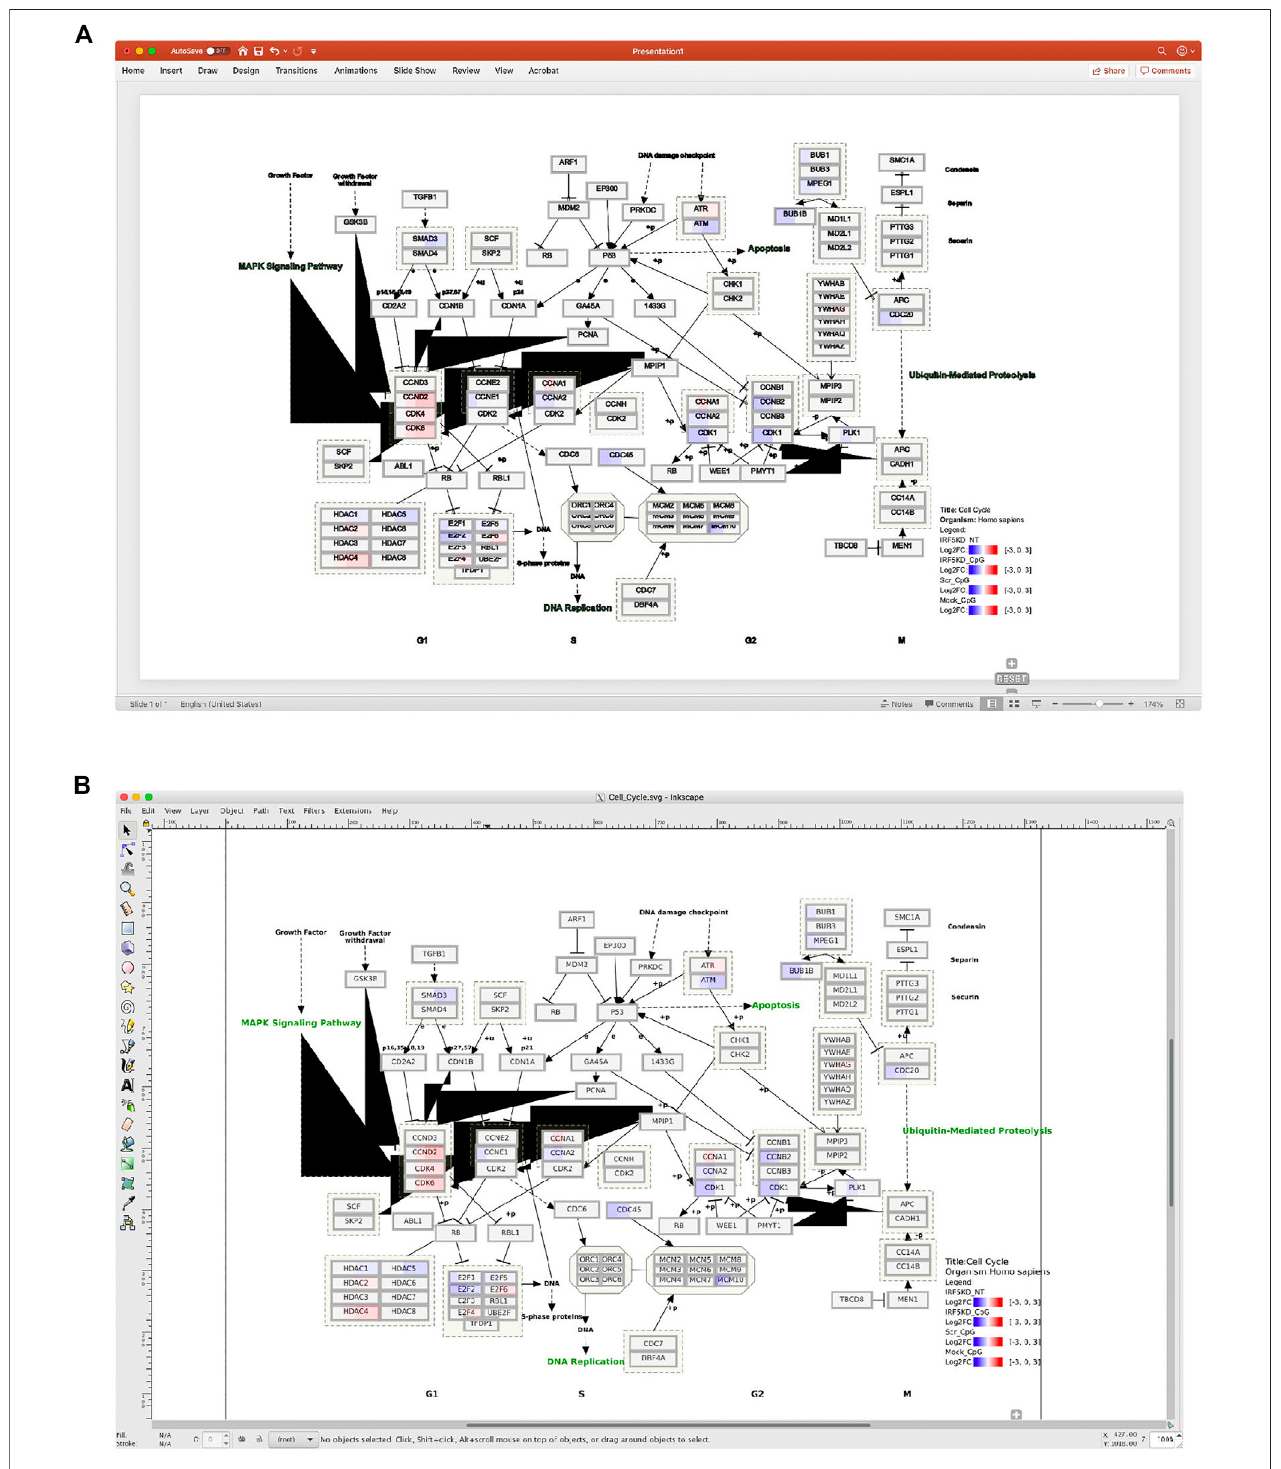
FIGURE 2 | An example of a pathway diagram from WikiPathways is not properly rendered by (A) Microsoft PowerPoint or (B) Inkscape. Please note the unexpected black triangles generated by both tools and loss of green color in the text (e.g., DNA replication) by PowerPoint, while the same Scalable Vector Graphics (SVG) image is rendered perfectly by bioInfograph as shown in Figure 1D .